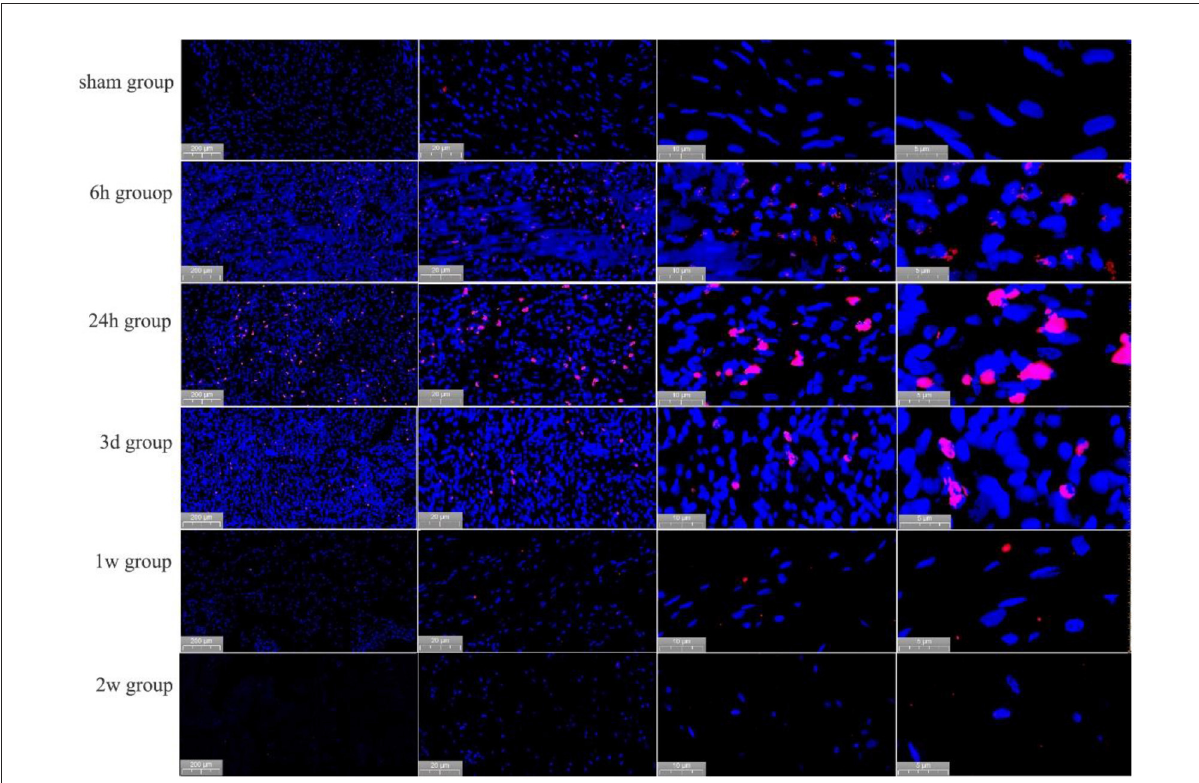
FIGURE5 Apoptosis of cardiomyocytes, as detected by TUNEL staining, at different time points in the PEF ablation region. Immediately after ablation, no apoptotic cells were generated; at 6h after ablation, apoptotic cardiomyocytes were seen; at 24h after ablation, significant apoptotic cells were seen; at 3 days after ablation, a significant decrease in apoptotic cells was observed; and at 1 ∼ 2 week after ablation, no apoptotic cells were seen. Positively apoptotic cells are cells with red-stained